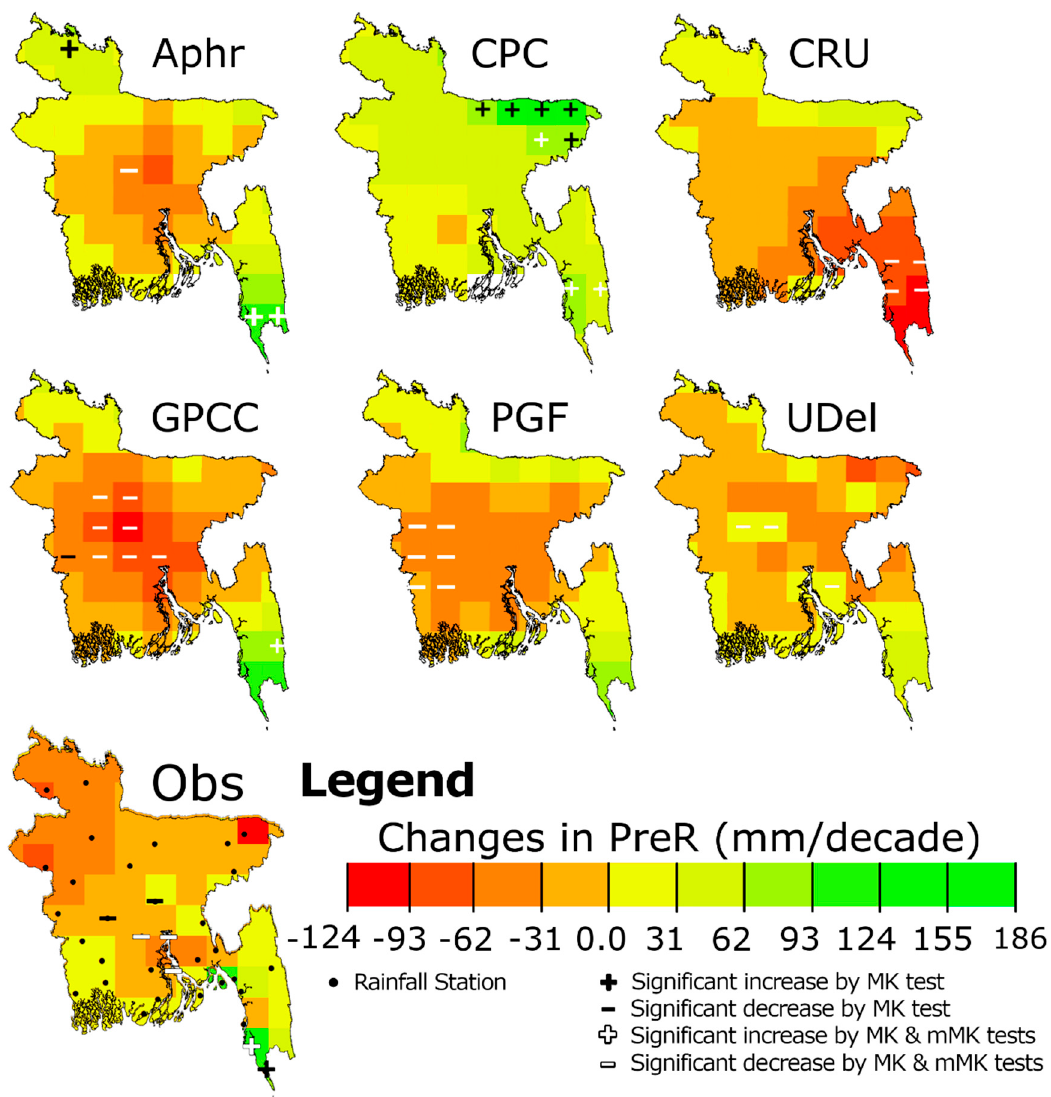
Figure 9. Trends in pre-monsoon rainfall (PreR) in Bangladesh during 1979–2010.